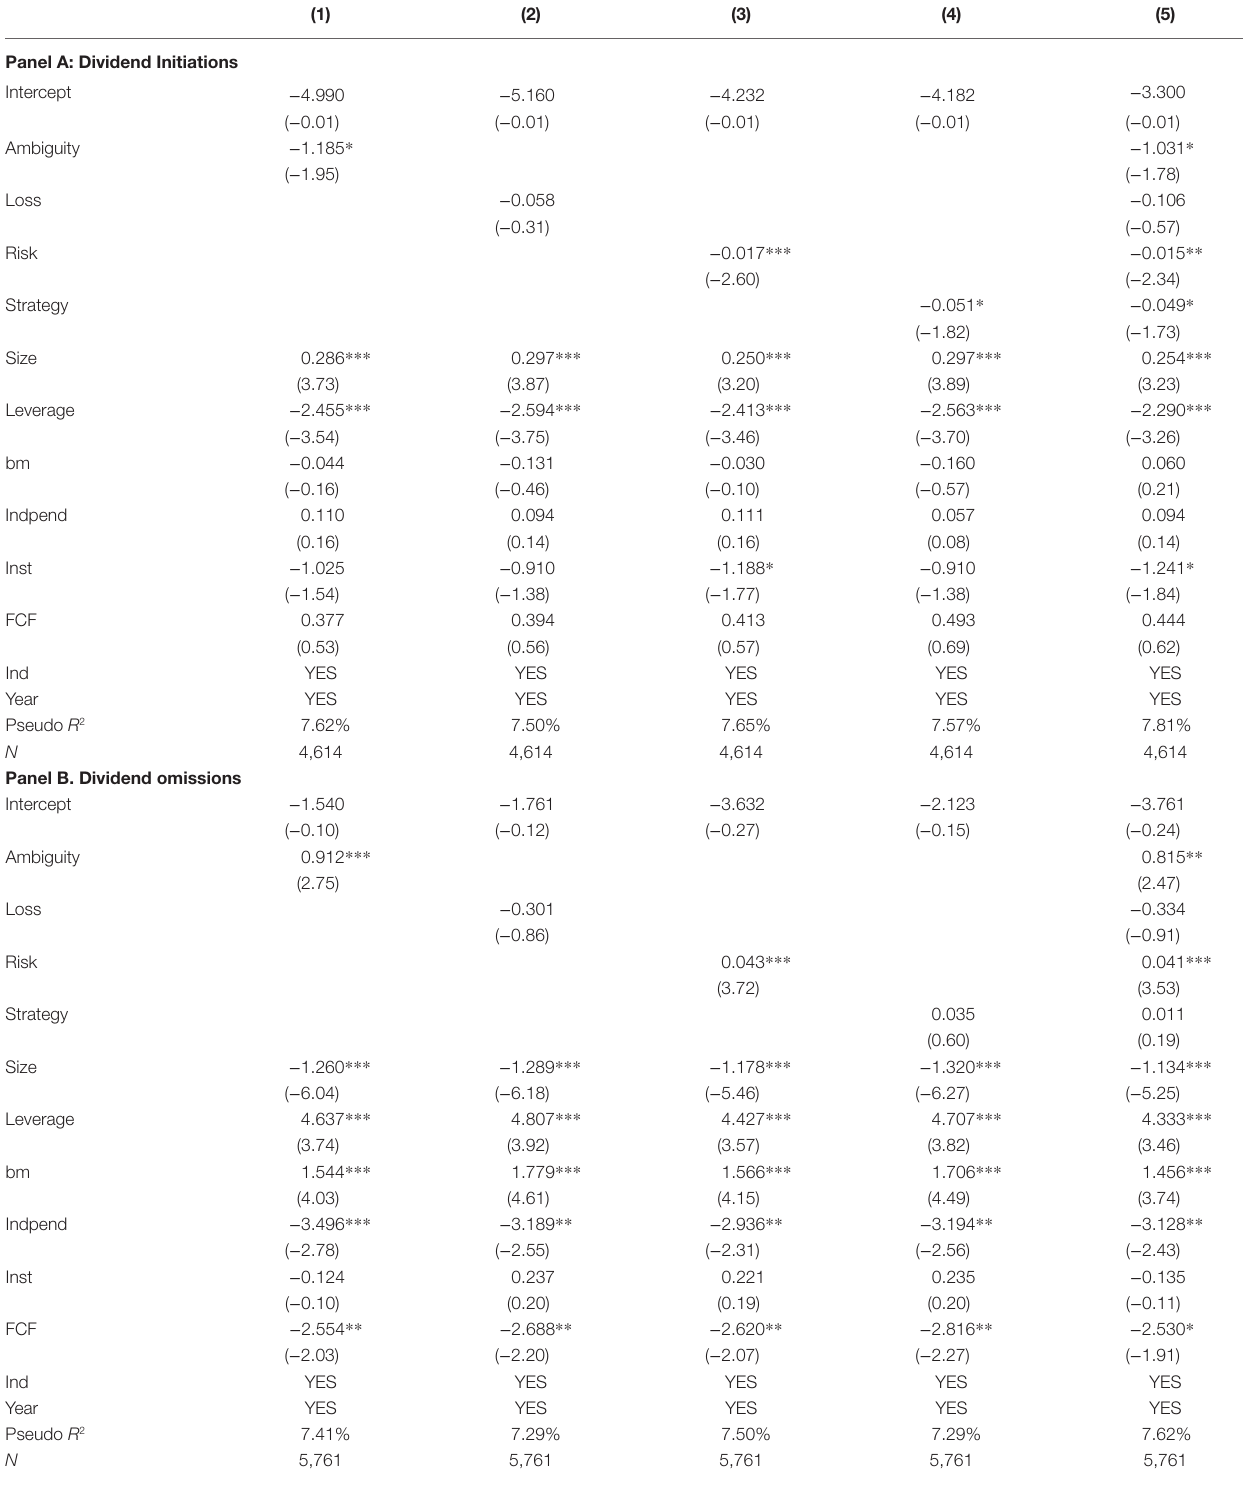
TABLE 5 | The influence of behavioral foundations and business strategy on the dividend initiations and